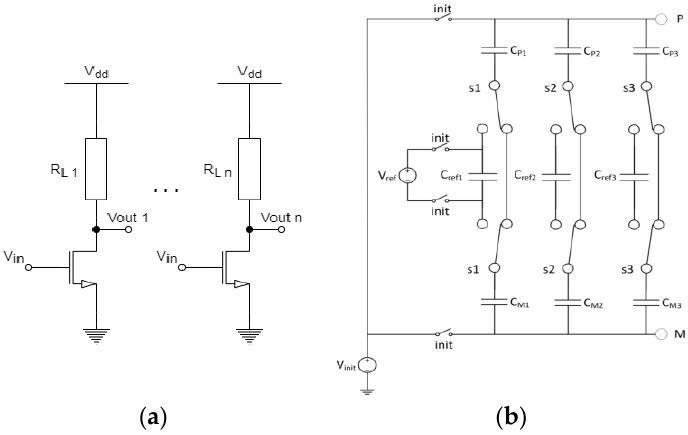
Figure 5. The circuit of: ( a ) a switched capacitor network PUF; ( b ) a DiffC PUF.